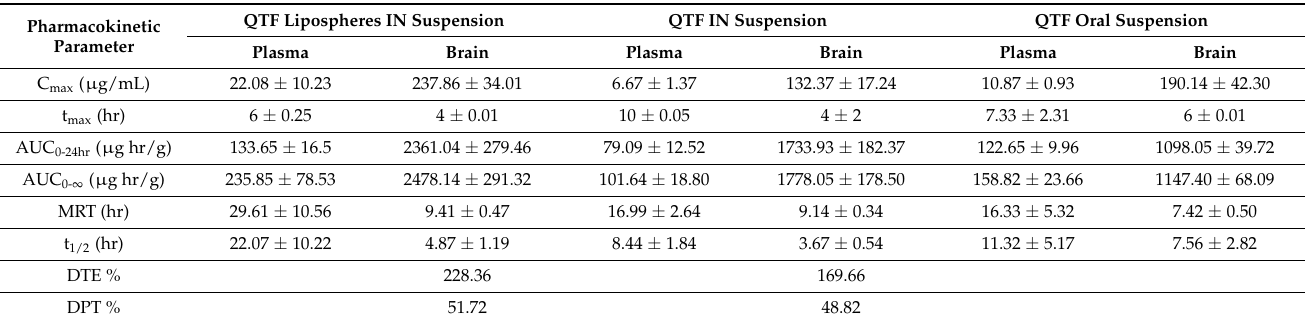
Table 5. Pharmacokinetic parameters of QTF in plasma and brain tissues after intranasal and oral